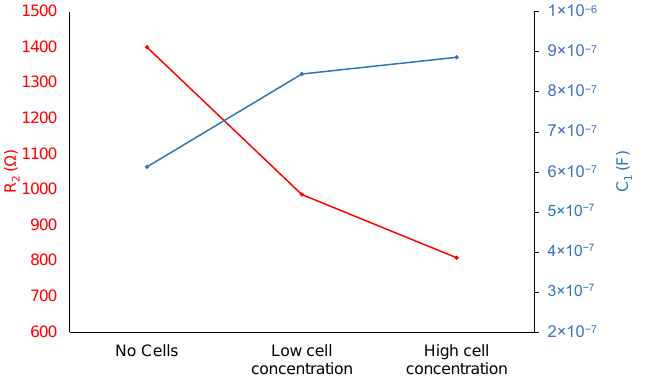
Figure 4. Complete equivalent circuit model, and resistance ( R 2 ) and capacitance ( C 1 ) values of the tissue RC model for BDL and sham-operated samples at the three studied time points.